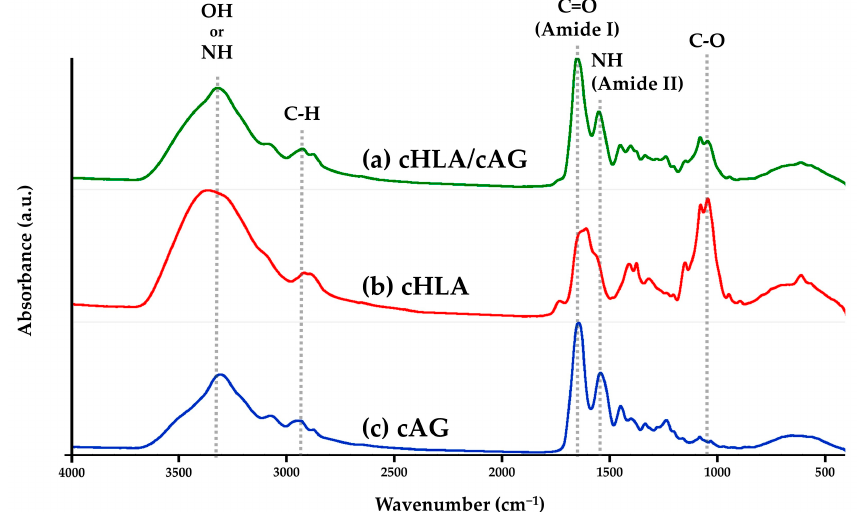
Figure 1. Fourier-transformed infrared spectroscopy (FTIR) charts of ( a ) cross-linked hyaluronic acid/cross-linked alkaline gelatin (cHLA/cAG), ( b ) cHLA, and ( c ) cAG. Note: Samples were cross- linked solids.